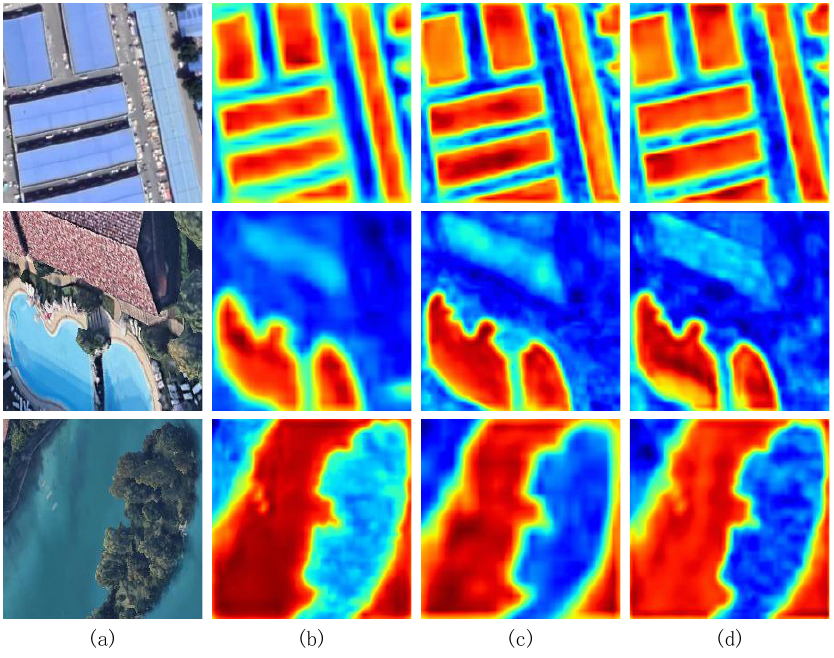
Figure 6. Visual contracts for different modules. ( a ) Test image; ( b ) method without MFFM and MCAM; ( c ) method without MCAM; ( d ) method with both MFFM and